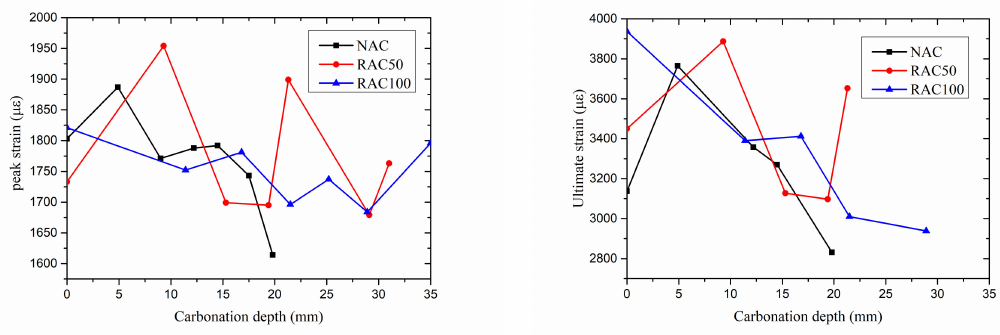
Figure 9. Peak strain and ultimate strain versus carbonation